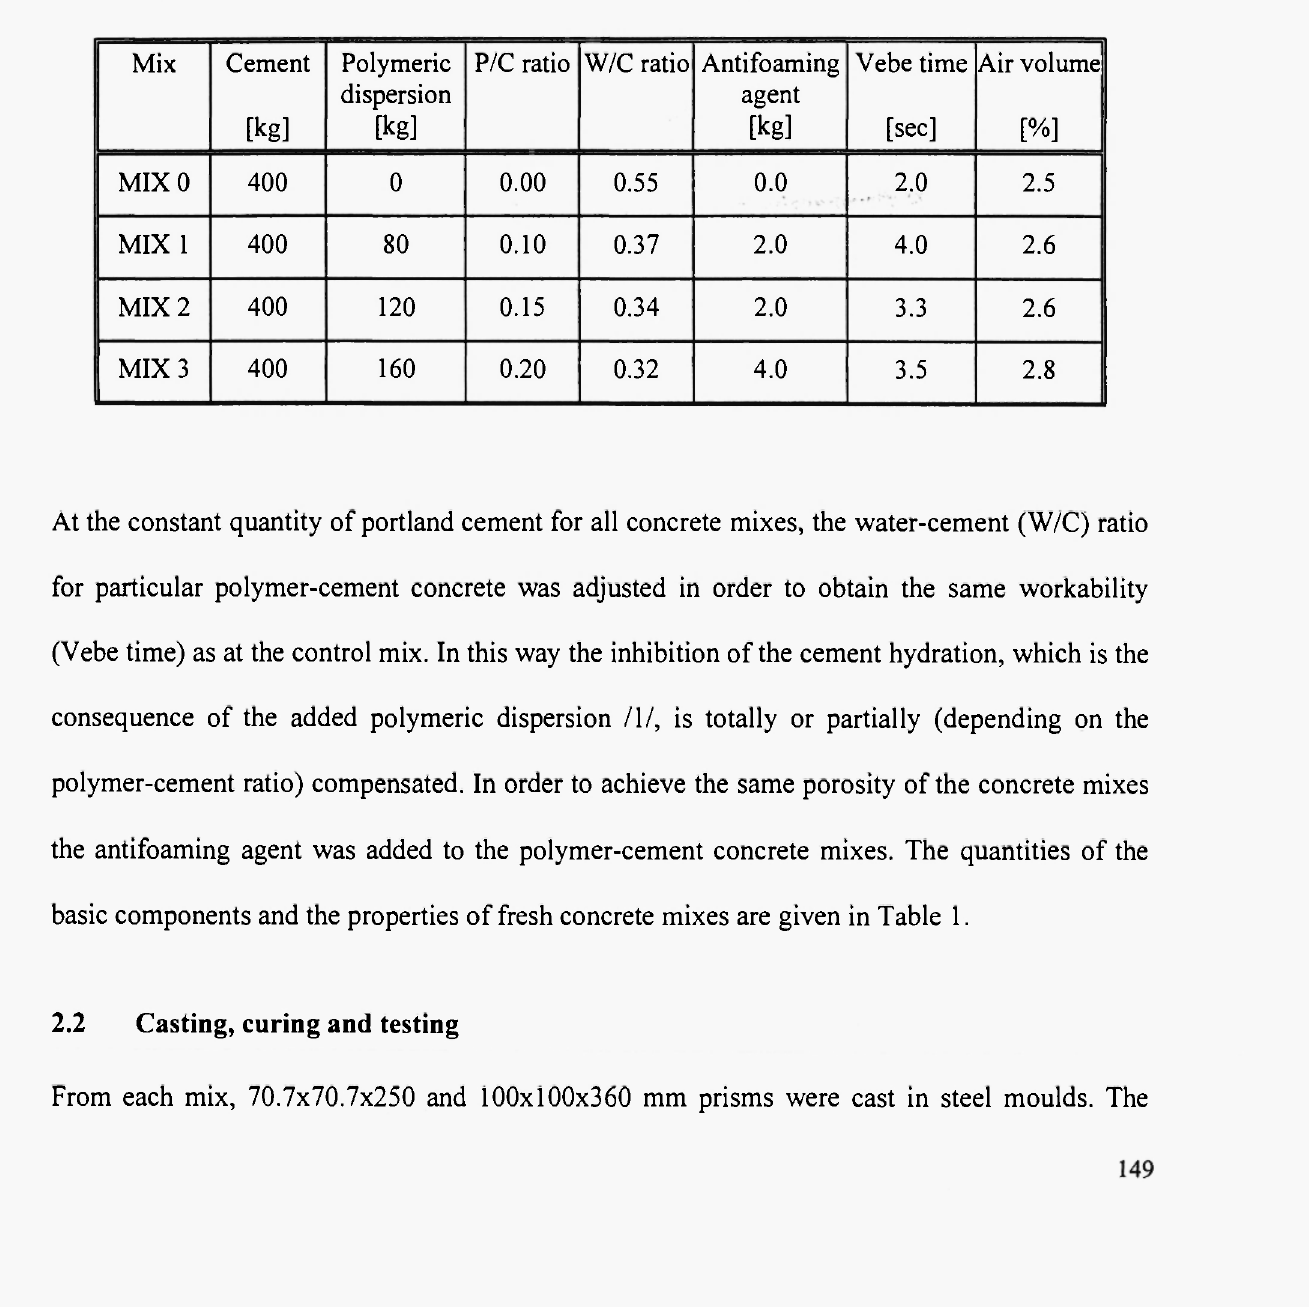
Table 1: Quantities of the basic components and properties offresh concrete